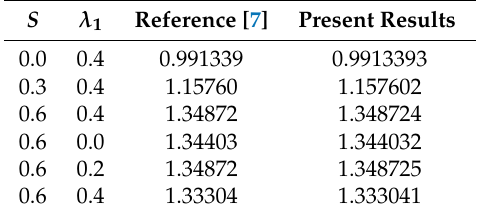
Table 1. Variations in C f , for R = Sr = M = Du = Sc = Du = 0.